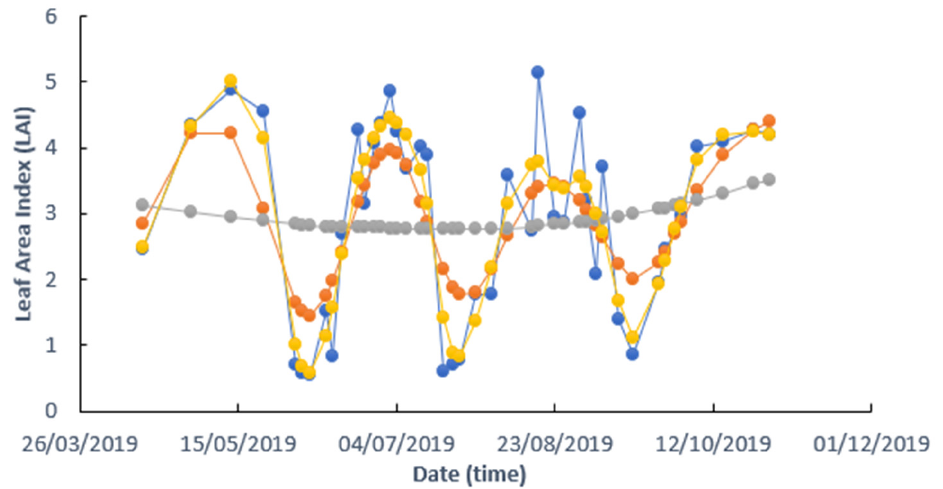
Figure 5. Effect of degrees of freedom ( df ) of the smoothed algorithms on LAI times series of an IPG pixel. In blue is the observed LAI; the smooth LAI times series with df equalling 5, 10 and 15 are in grey, orange, and yellow, respectively. Table 3. Calibration performance after the first and second phases on the calibration data set. TG represents well ‐ classified irrigated grassland polygons; FG, polygons classified as irrigated grass ‐ land while not an irrigated grassland; TNG, well classified not irrigated grassland polygons; FNG, irrigated grassland polygons classified as not irrigated grassland.